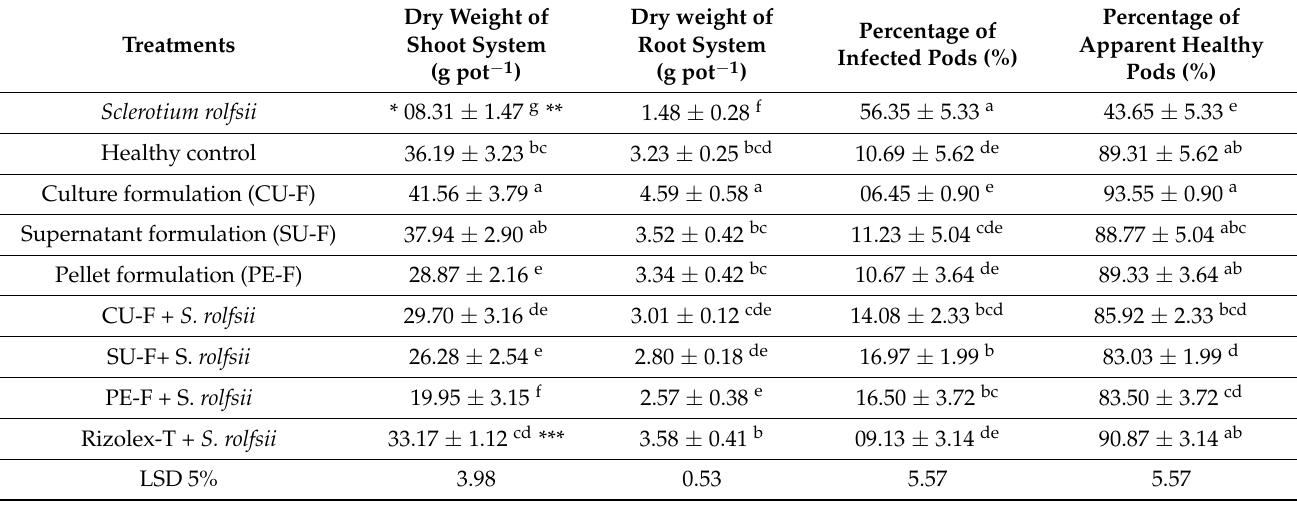
Table 3. Effect of treatment with talc-based formulations of Streptomyces cellulosae Actino 48 on dry weight of shoot and root system, and peanut pods rot incidence (%) under artificial infection and greenhouse conditions.